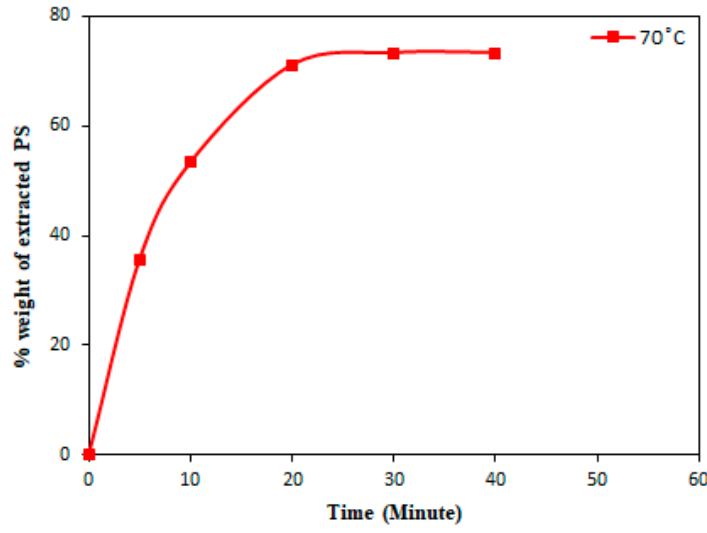
Figure 14. Mass loss of PS binder from SS 17-4PH / 3YSZ micro-part at optimal solvent debinding temperature.